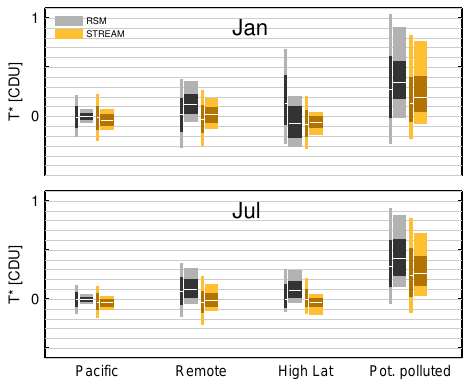
Figure 16. Regional statistics of GOME tropospheric residues T ∗ from different algorithms for January (top) and July (bottom) 1999. Conventions as in Fig.